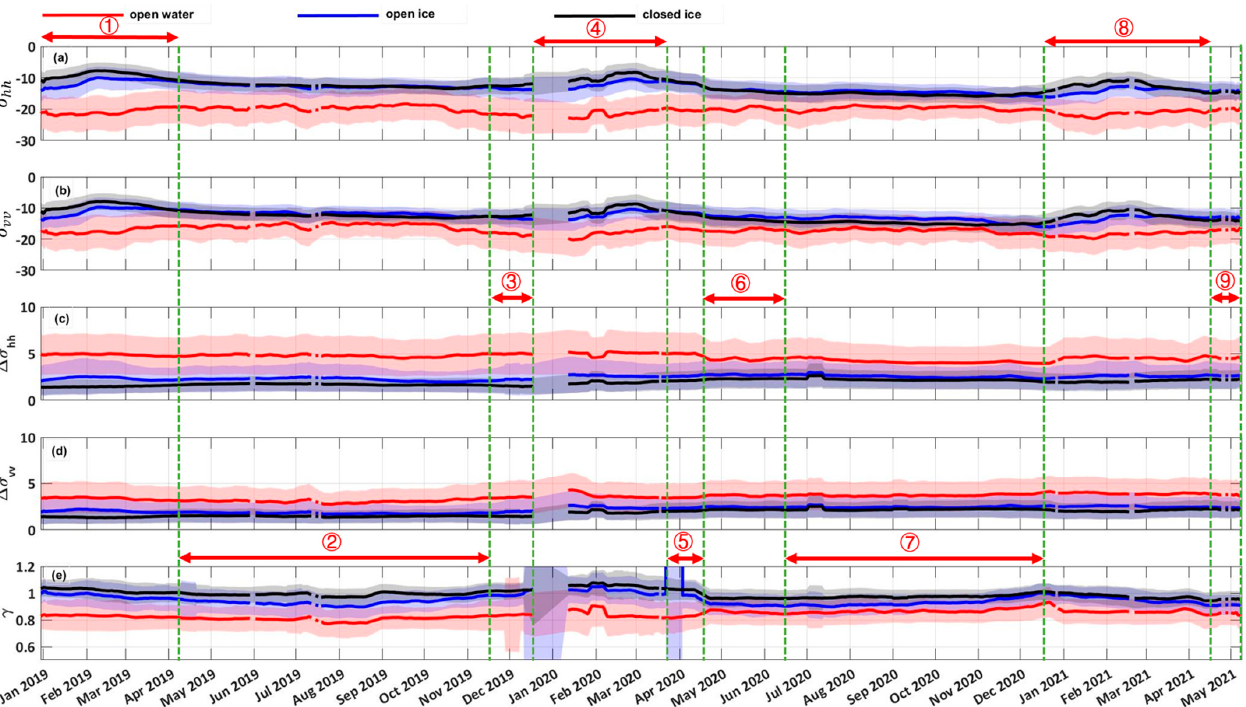
Figure 7. The mean values (solid lines) and standard deviations (shaded areas) of Antarctic sea ice distribution feature parameters from 1 January 2019 through 10 May 2021 ( a ) σ hh , ( b ) σ vv , ( c ) ∆ σ hh , ( d ) ∆ σ vv , ( e ) γ . The red, blue, and black marked results represent open water, open ice, and closed ice, respectively. The double arrows represent the most significant feature parameters in different time periods.